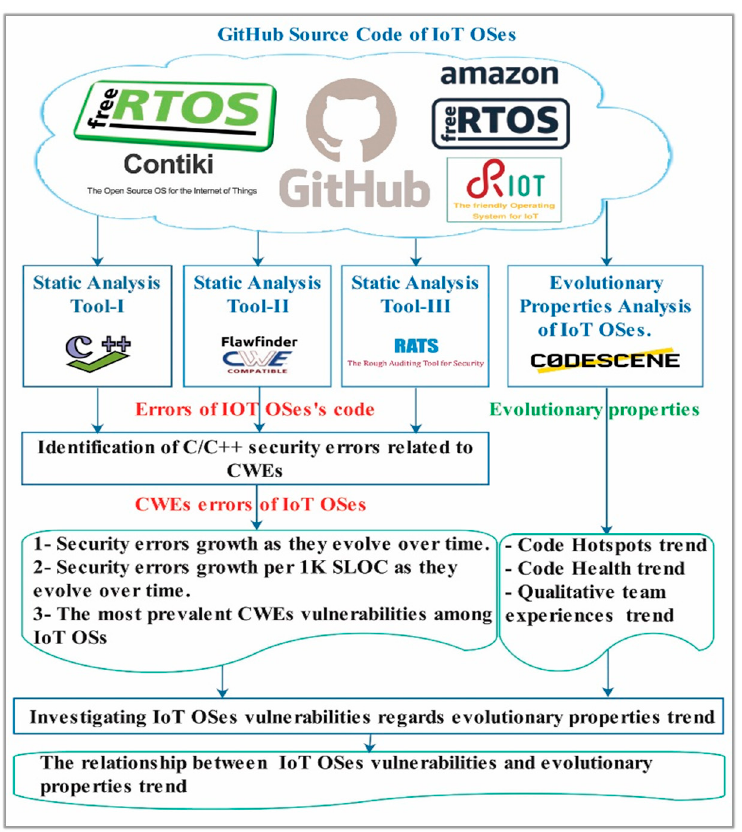
Figure 3. Methodology of finding and investigating IoT OSs security vulnerabilities.